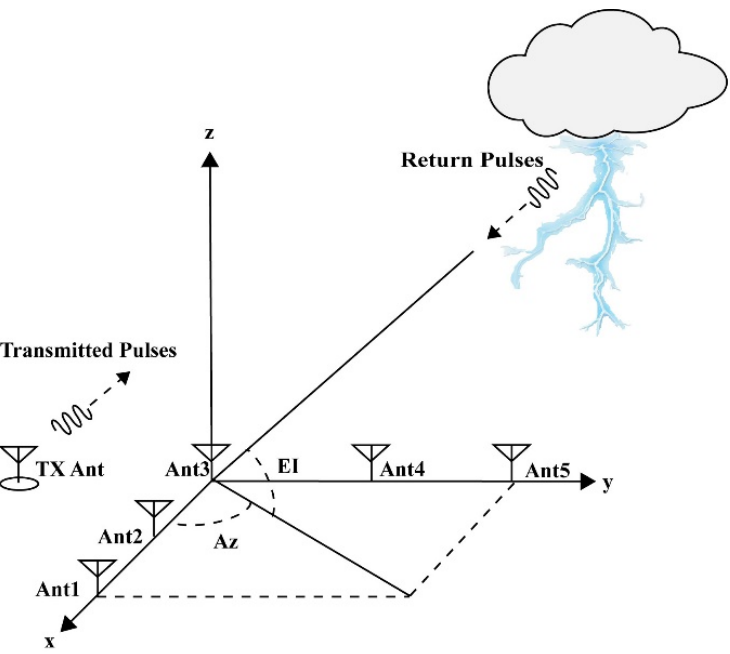
Figure 1. The configuration of interferometric VHF radar for lightning detection and imaging.